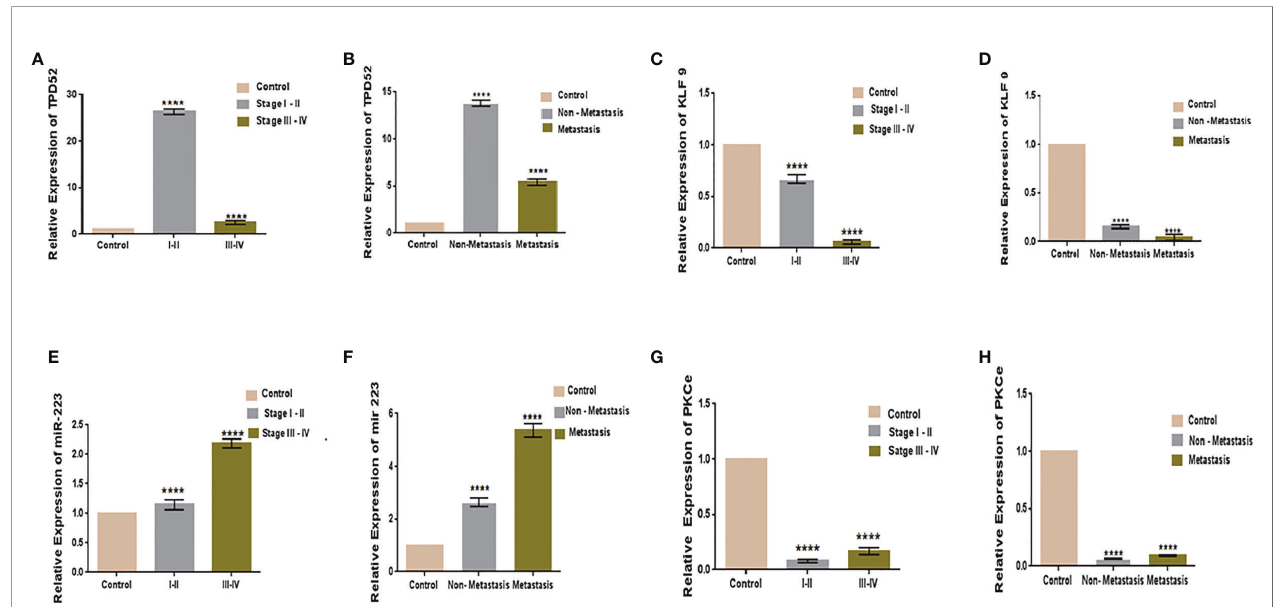
FIGURE 7 | Relative gene expression with clinical features of cervical cancer. Relative TPD52 expression with tumor stage (A) and metastasis (B) . Relative KLF9 expression with tumor stage (C) and metastasis (D) . Relative miR-223 expression with tumor stage (E) and metastasis (F) . Relative PKC ϵ expression with tumor stage (G) and metastasis (H) . Fold change is plotted on the y -axis and study groups on the x -axis. Illustrative data are presented as the mean ± SEM of triplicate experimentations. Statistical signi fi cance was measured by ordinary one-way ANOVA (**** p <